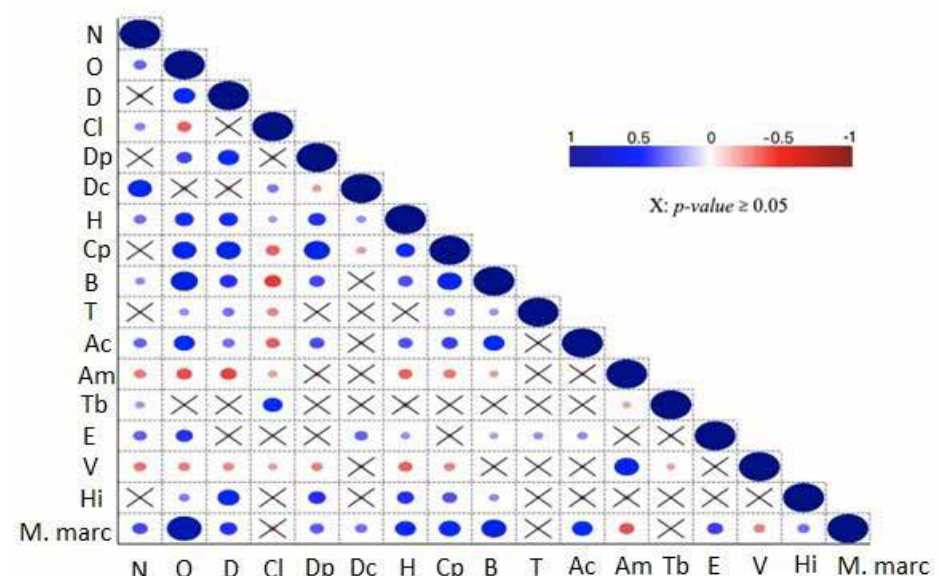
Fig. 6: Spearman correlation matrix between abundances of macroinvertebrate orders and M. marcella (p-value ≤ 0.05 blank). N: Neotaenioglossa. O: Odonata. D: Diptera. Cl: Calanoida. Dp: Diplostraca. Dc: Decapoda. H: Hemiptera. Cp: Coleoptera. B: